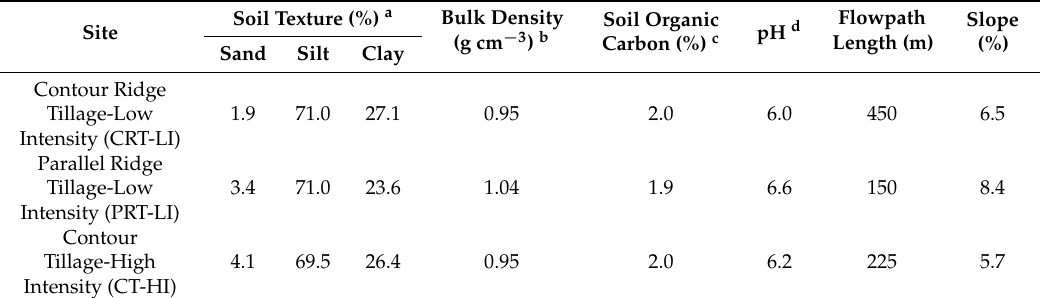
Table 1. General site characteristics.